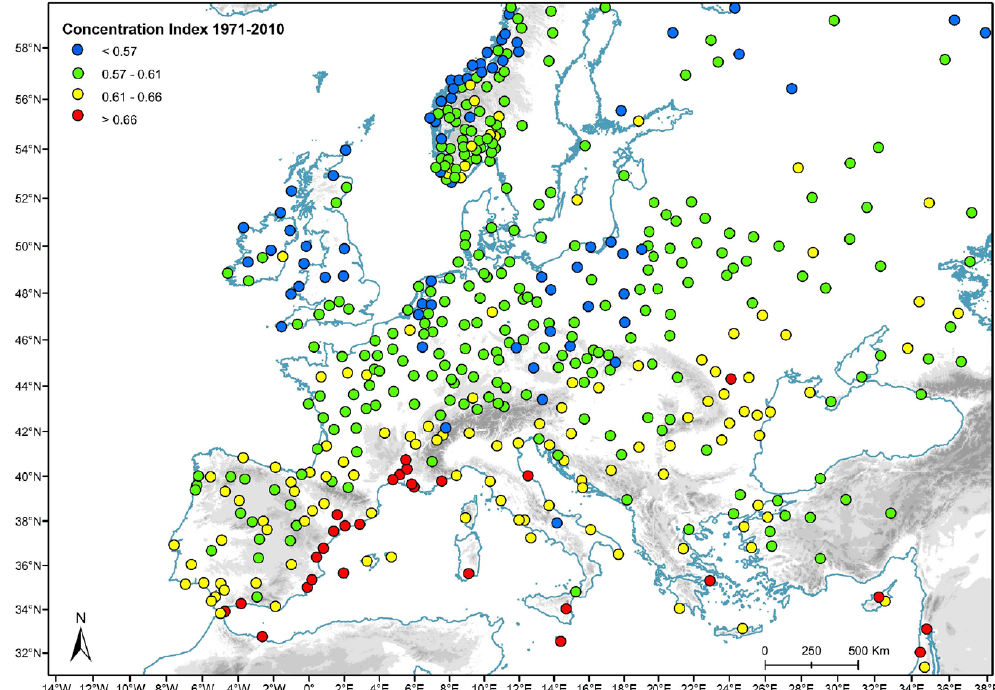
Fig. 7. Autumn CI values distribution. Each colour corresponds to a different interval: CI values 0.56 or lower (blue dots), between 0.57 and 0.61 (green dots), between 0.62 and 0.66 (yellow dots), and 0.67 or higher (red dots).